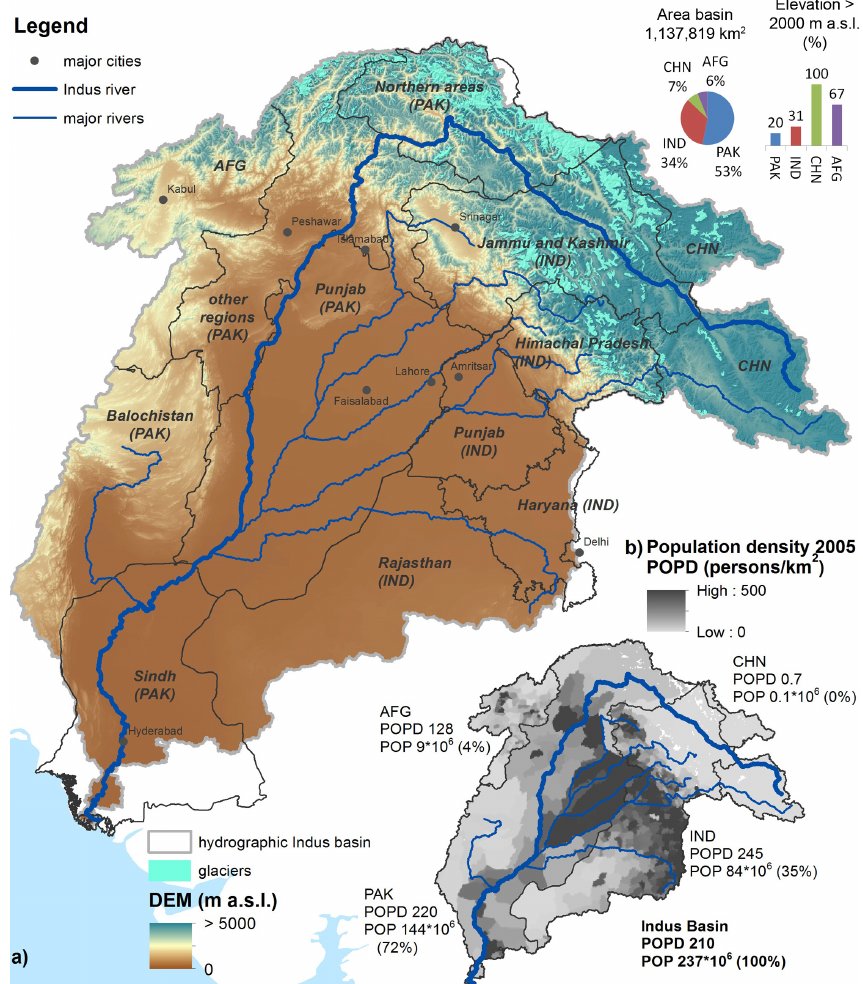
Fig. 1. (a) Overview of the DEM and location of political borders of the Indus river basin (boundaries based upon topography, as provided by the IWMI); (b) population density POPD (persons per km 2 ) in 2005 according to CIESIN (2005), POP=total population in 2005 based upon the GPWv3 dataset (CIESIN, 2005); country codes according to the UN: AFG=Afghanistan, CHN=China, IND=India,